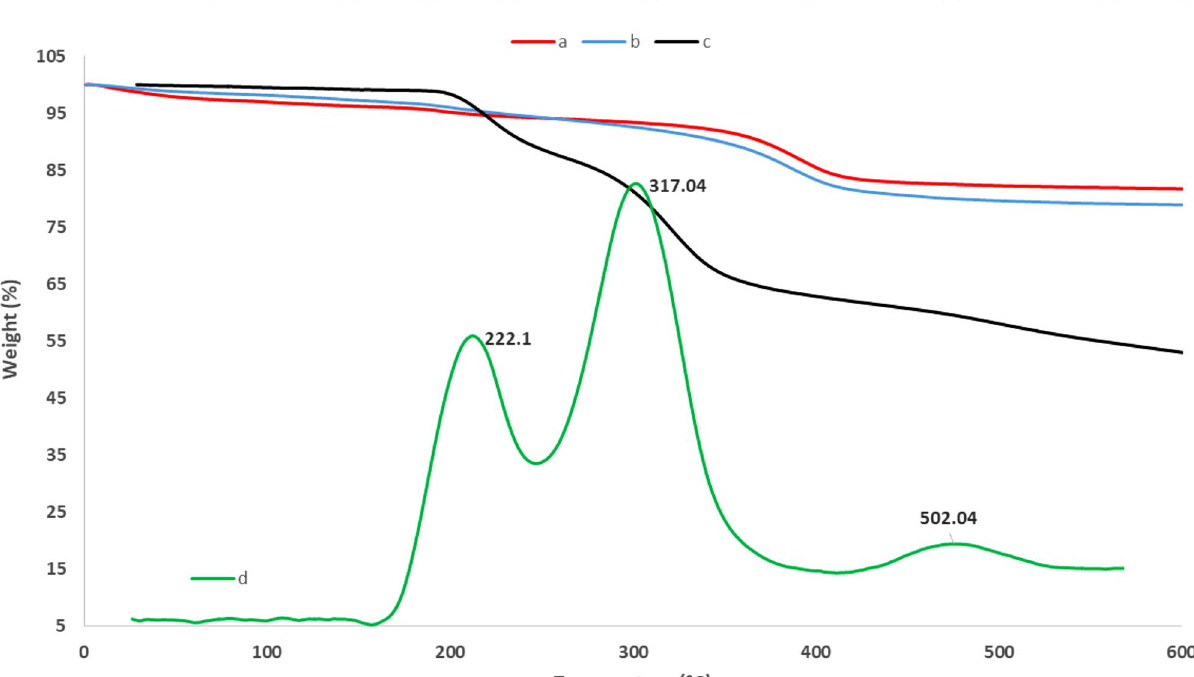
Figure 5. The TG analyses of (a) pure HNTs, (b) HNT-Cl, (c) CuI@HNT-TSC-PC and (d) DTGA spectra of